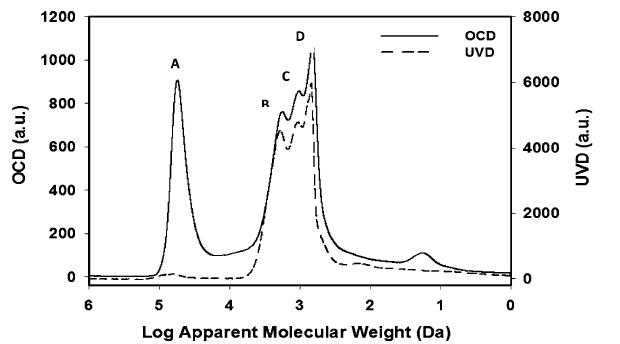
Fig. 3 HPSEC-OCD and -UVD of slow sand filter effluent